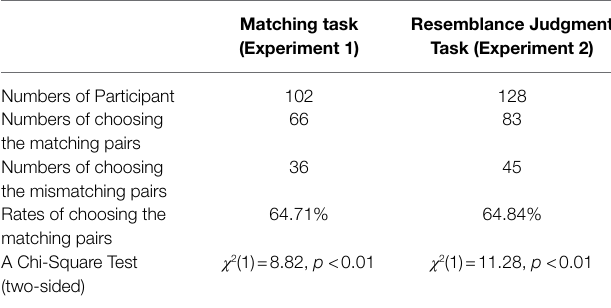
TABLE 1 | Results of Experiments 1 and